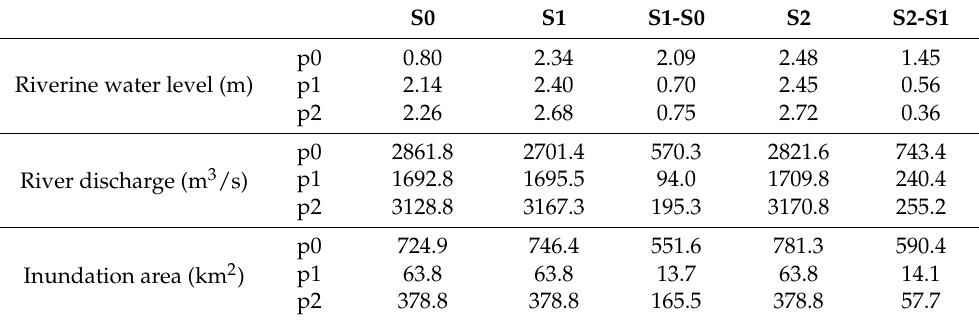
Table 2. Quantitative comparison between different scenarios in terms of riverine water level, river discharge, and inundation at a daily scale. p0, p1, and p2 represent the points in Section 3.2 and the area indicated in Figure 10. Note that the values are the maximum value extracted during Typhoon Lekima (3–15 August). For each variable, the maximum value for each scenario (S0, S1, and S2), and the maximum difference between scenarios (S1-S0 and S2-S1) are listed to represent the tidal effect and surge effect, respectively. For the inundation area, the number represents the total area for each scenario and the area with increasing inundation